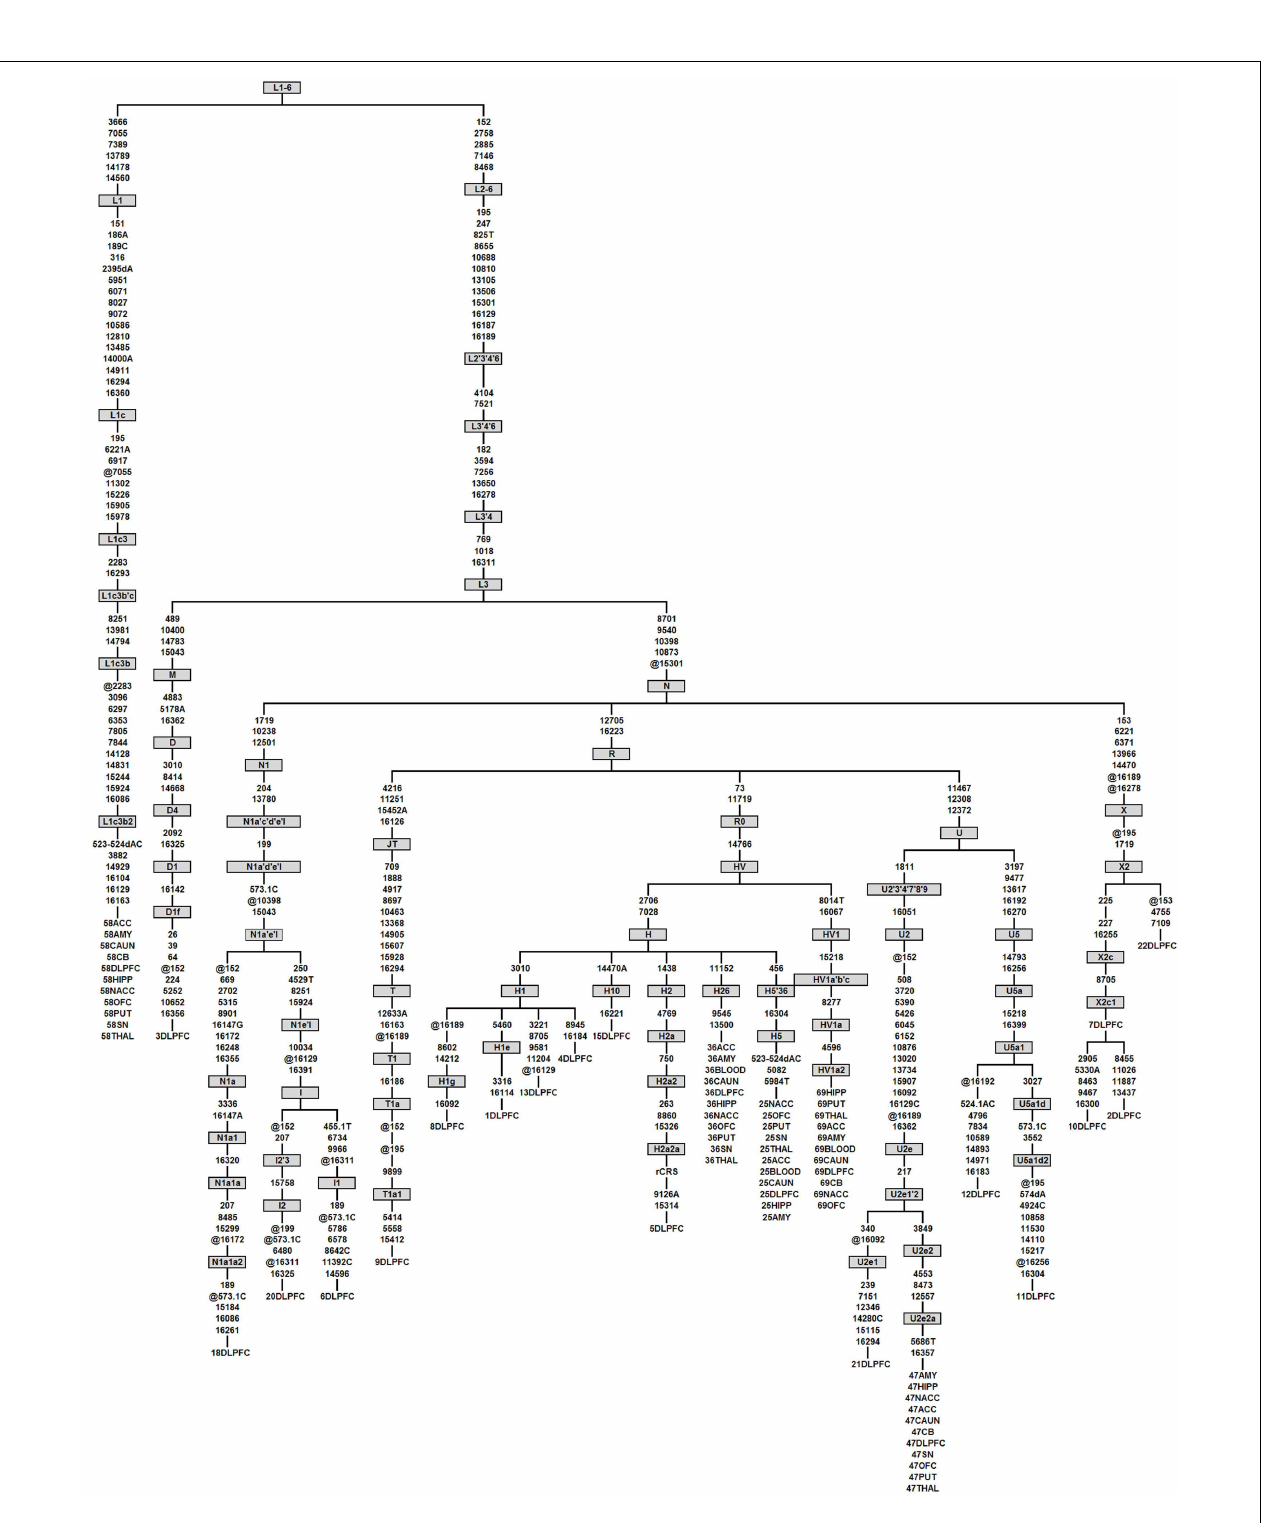
309.1C, 315.1C, 16182C, 16183C, and 16519 were not considered for tree construction and are therefore not shown.The samples that have appeared in the study are given numerical labels followed by brain region abbreviations. As an example, in the first column individual 58, belonging to haplogroup L1c3b2, was sequenced in 11 brain regions which all showed the same phylogenetic relationship, indicating a lack of novel mutations between brain regions from the same